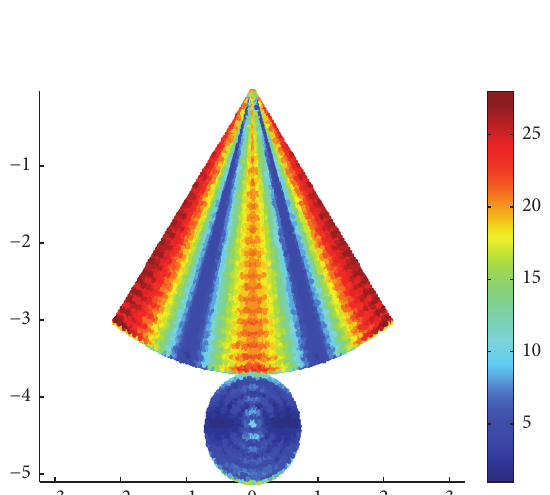
Figure 5: Unfolded fan.